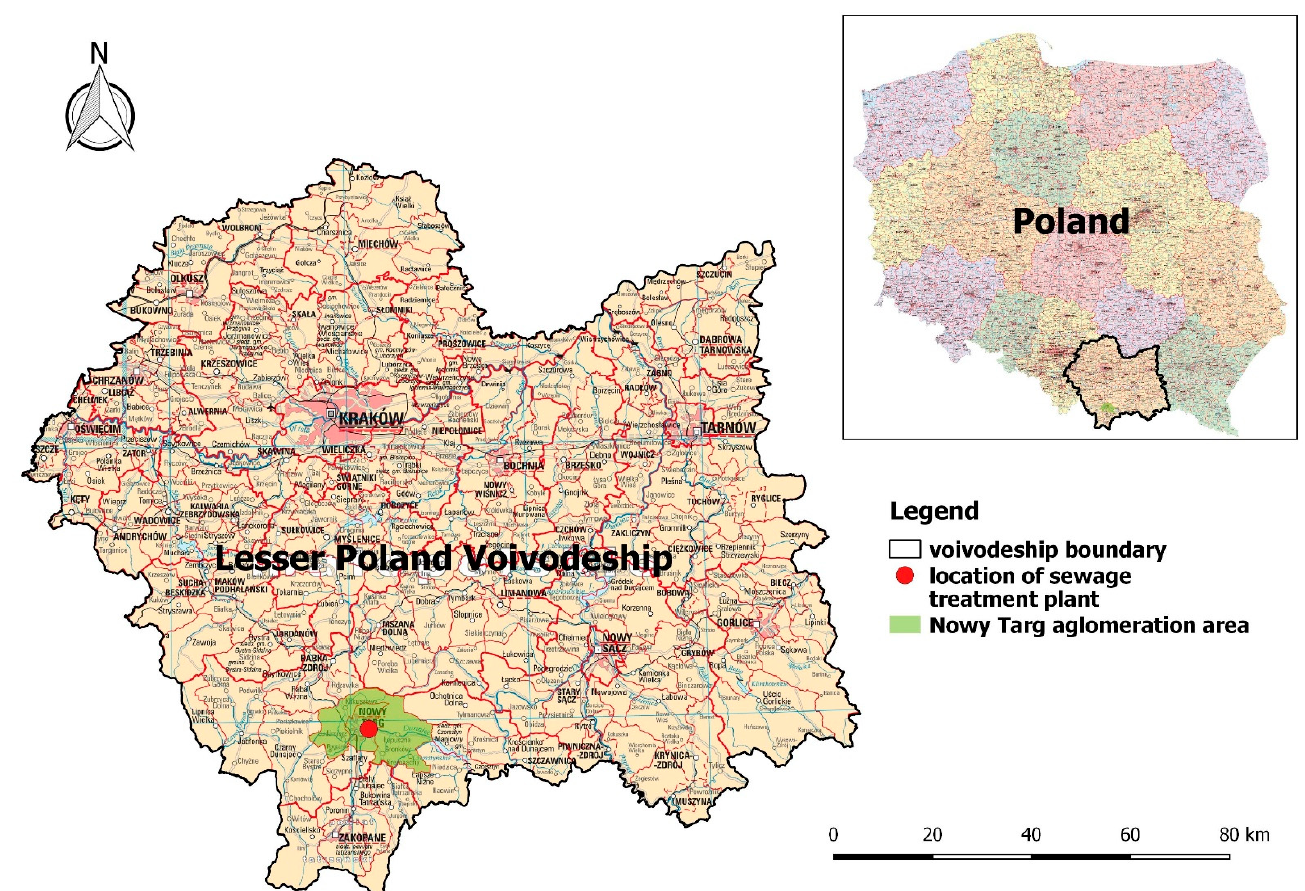
Figure 1. The location of the rural agglomeration of Nowy Targ against the background of the Lesser Voivodeship and Poland [source: own study].